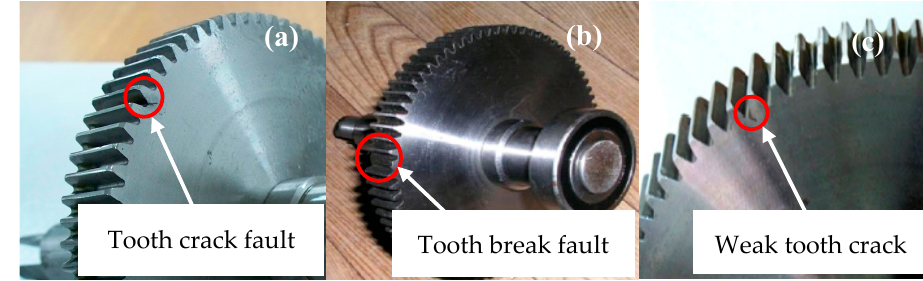
Figure 11. Typical gear faults. ( a ) Tooth crack fault ( b ) Tooth break fault and ( c ) Weak tooth crack fault. Table 2. Description of the gearbox operating condition.